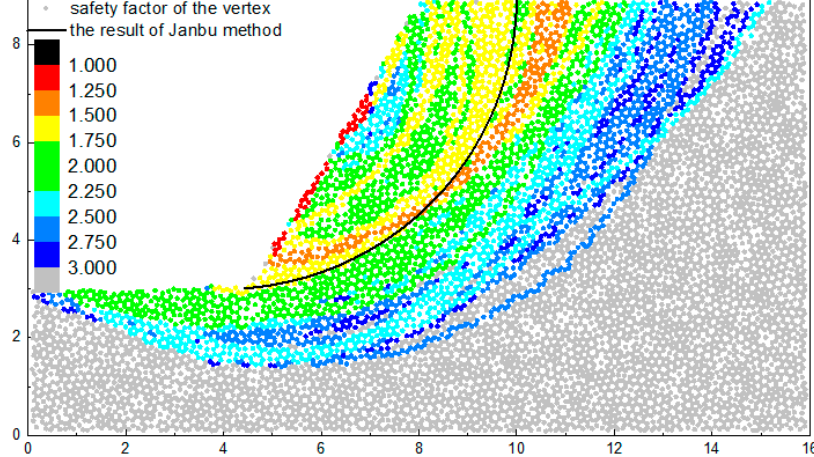
Figure 16. The safety factors on the condition that the internal friction angle is transferred to half of its previous value.